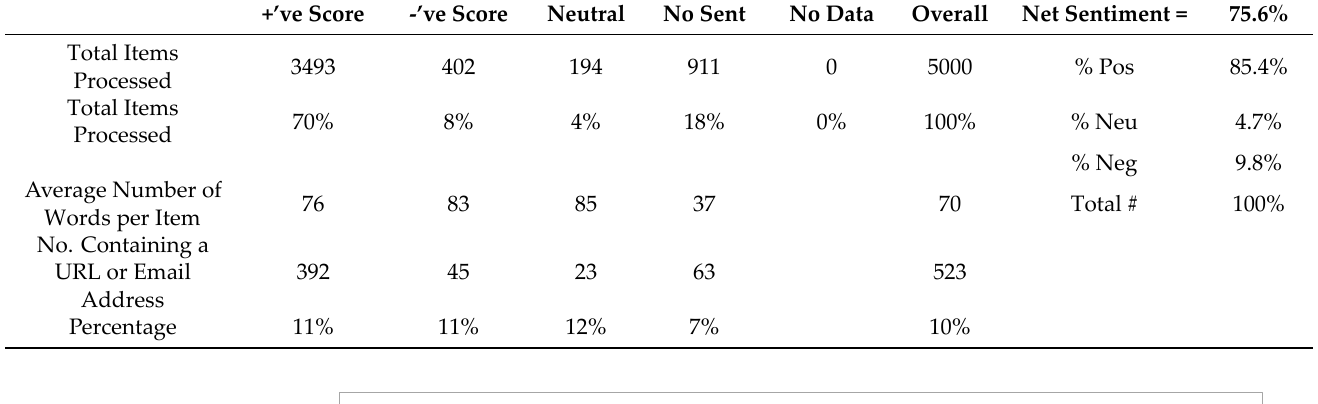
Table 5. Source data.